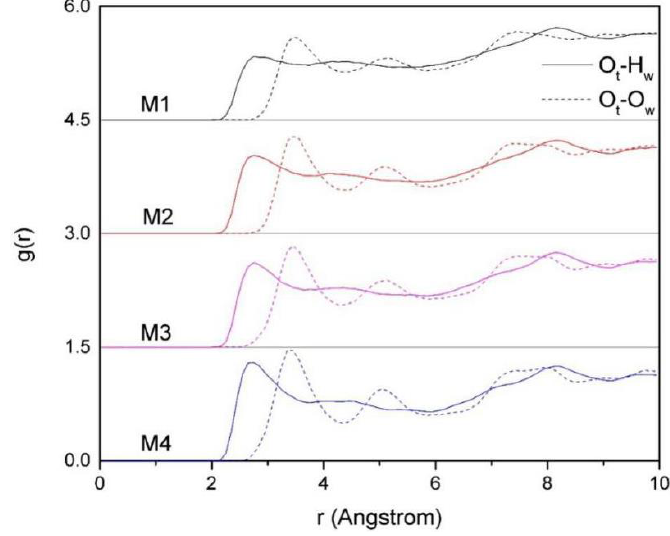
ff erent layer charge